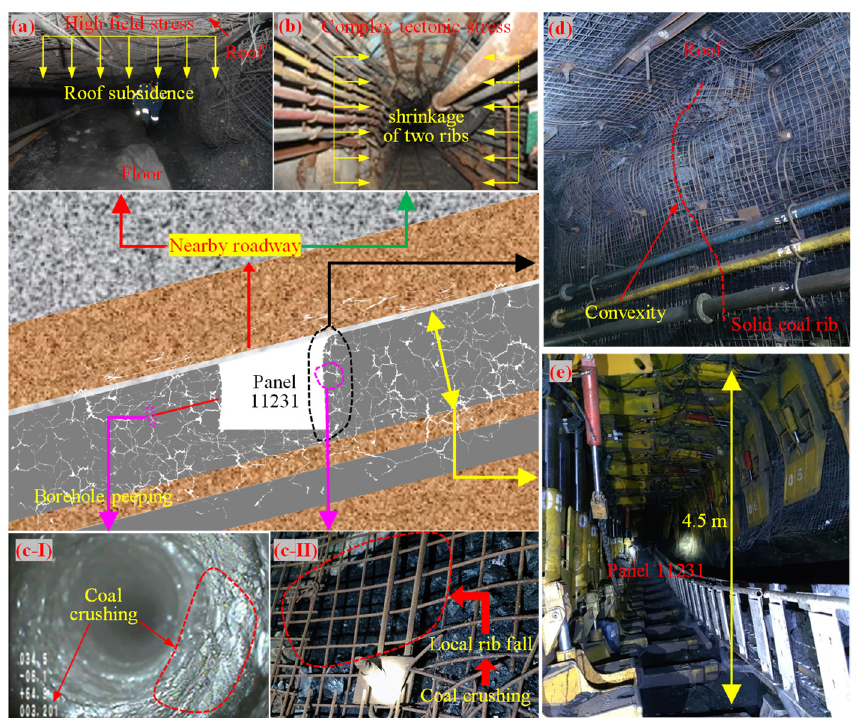
Figure 5. Schematic for the analysis of surrounding rock failure difficulties of headgate 11231. ( a ) Roadway deformation caused by high field stress; ( b ) Roadway deformation caused by complex tectonic stress; ( c - Ⅰ ) Borehole peeping; ( c - Ⅱ ) Crushed coal; ( d ) Large deformation of roadway rib; ( e ) Large mining height.